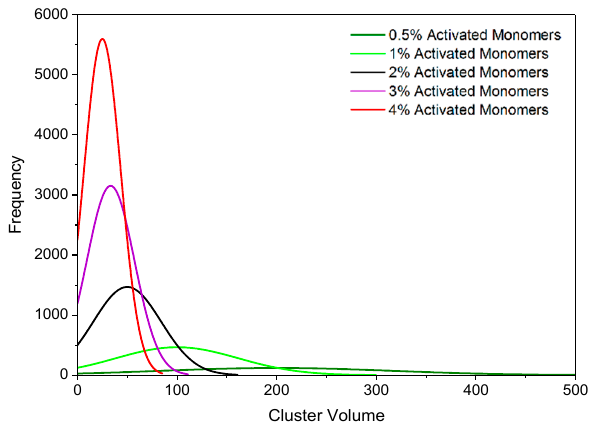
Figure 2. Histogram plots of primary cluster volume distributions at activated monomer ( C c ) values of 0.5%–4%. Data are presented for 60% solids content ( S c ).